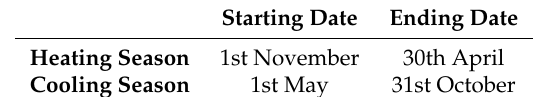
Table A2. Cooling and heating season periods.